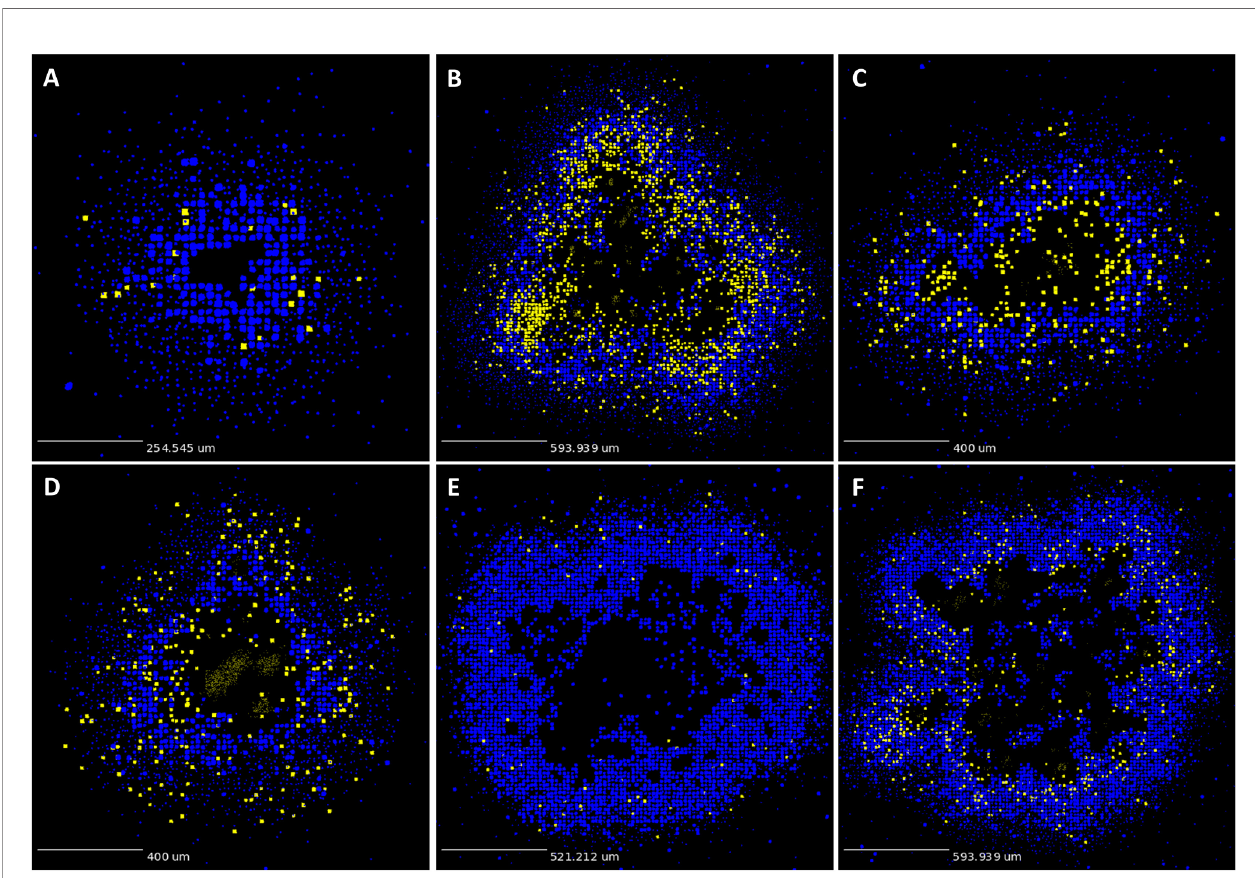
FIGURE 3 | GranSim produces simulated granulomas that re fl ect granulomas in experimentally-infected macaques. Panels (A – F) show six sample simulated granulomas drawn from the full parameter set (see Table 2 and Online Supplement Table 1 ), shown at 200 days post-infection. Neutrophils are indicated in yellow and all other cell types are indicated in blue, in order to correlate with the color scheme used for the IHC images in Figure 2 . Extracellular Mtb visualized as pale yellow patches. Caseum not